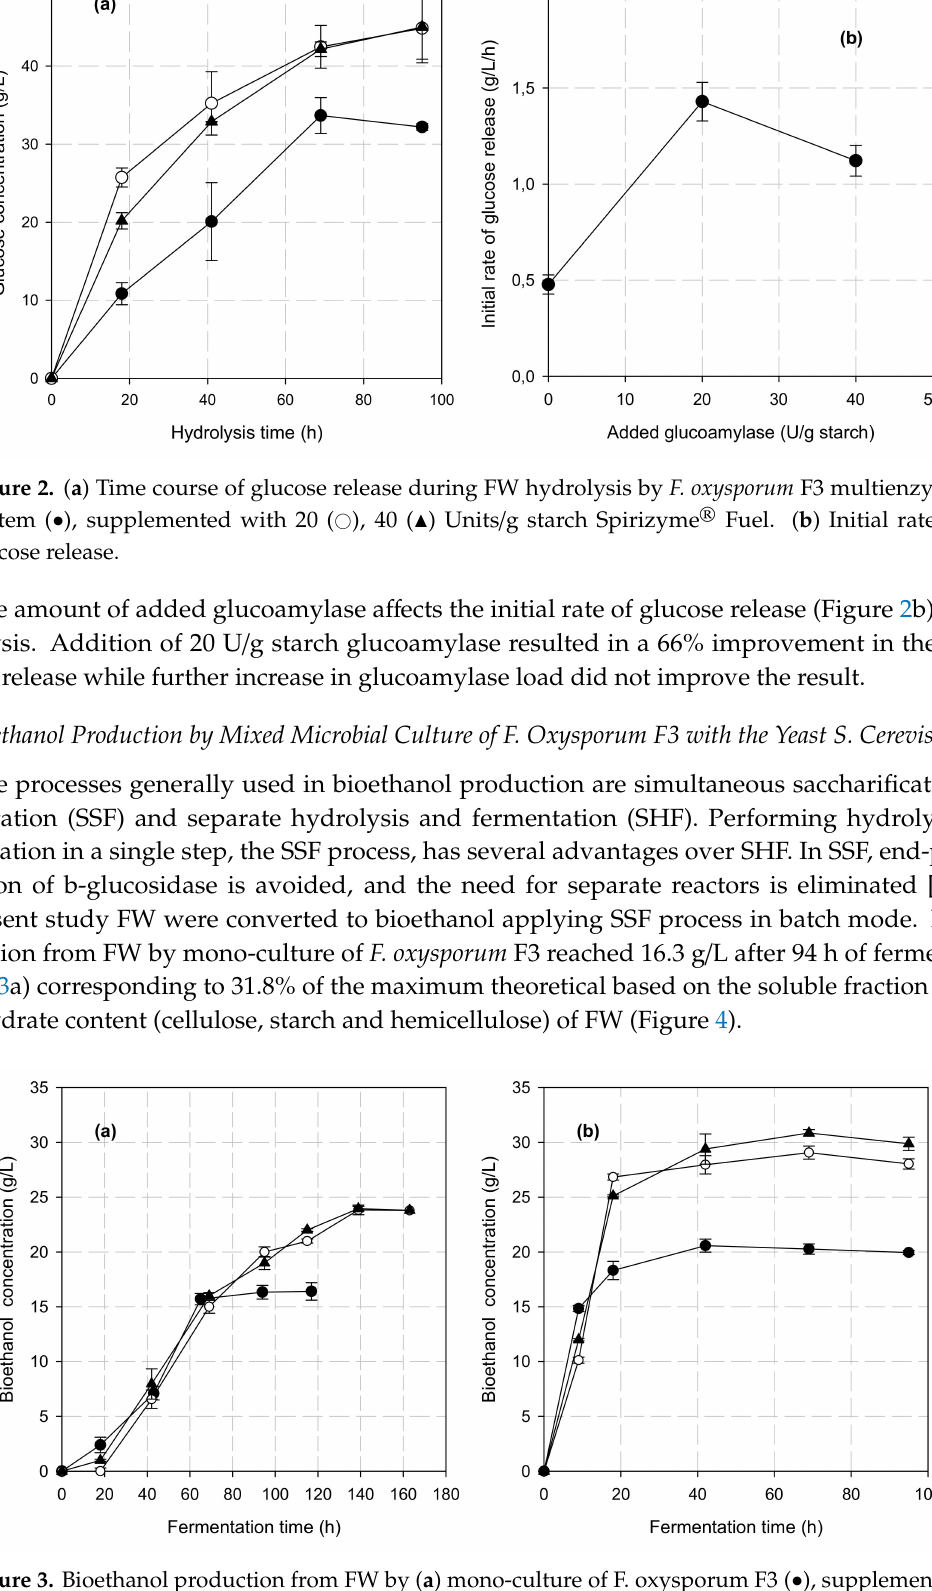
) and 40 ( (cid:78) ) Units / g starch Spirizyme ® (cid:35)